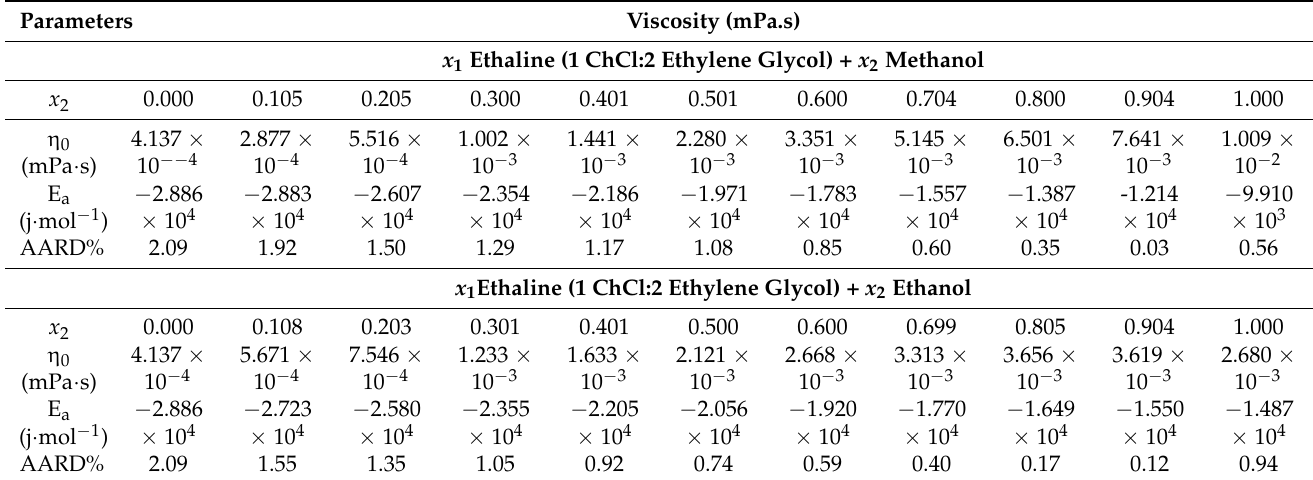
Table 4. The optimized values of the Arrhenius-like viscosity model (Equation (1)), and AARD% for the investigated mixtures of Ethaline + methanol/ethanol at each investigated concentration. Parameters Viscosity